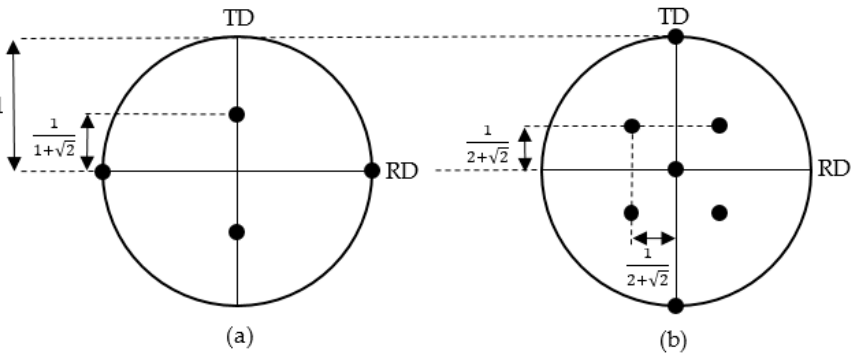
Figure 2. Pole figures corresponding to the Goss texture represented in Figure 1. ( a ) Crystallographic plane (001), ( b ) crystallographic plane (011).